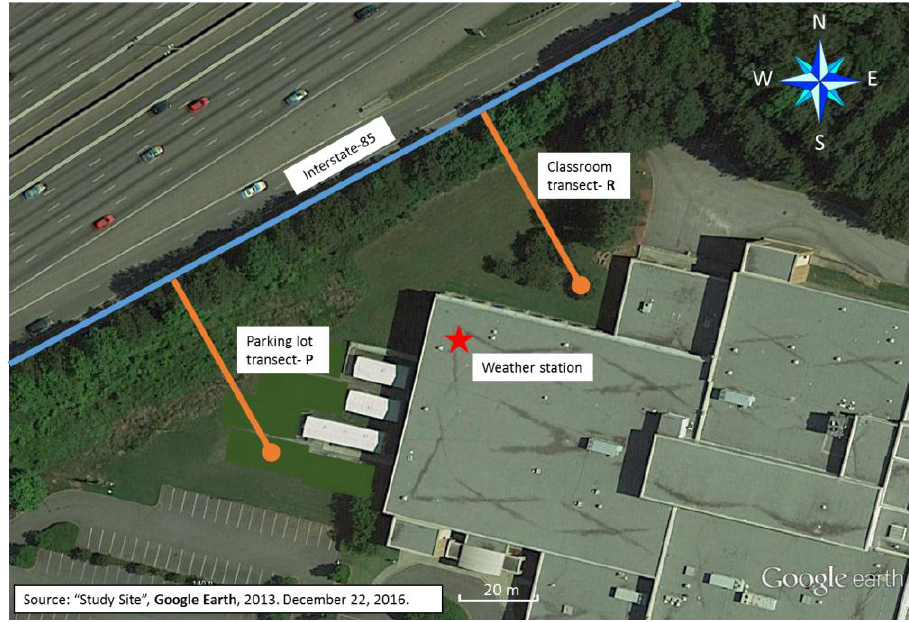
Figure 1. Study site and monitoring transects.